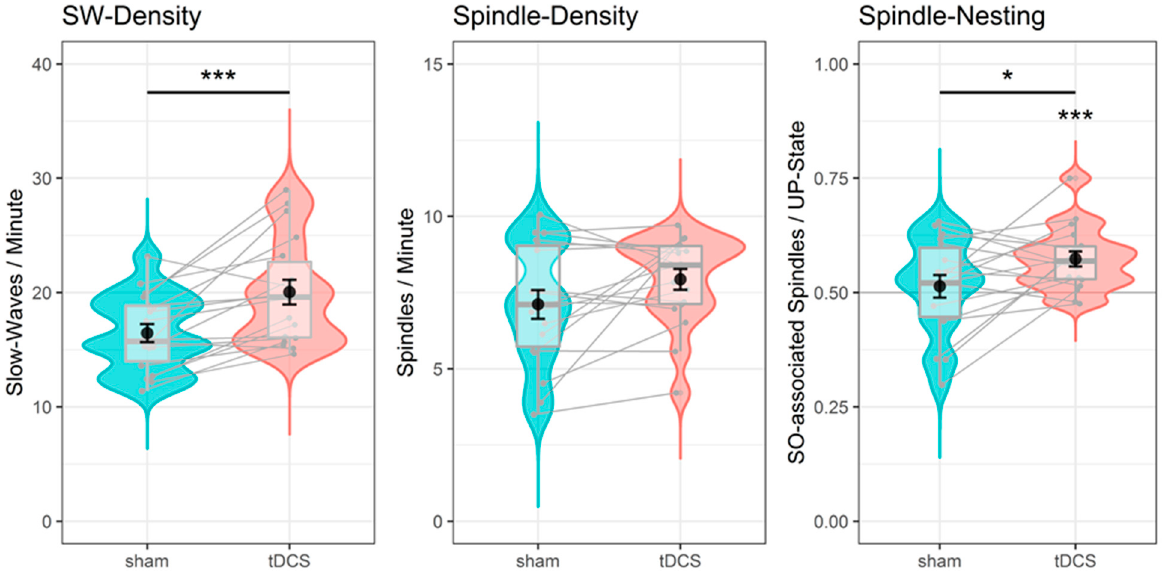
Figure 4. Effect of tDCS on sleep parameters. Slow-wave density ( left panel ), spindle density ( middle ), and nesting of slow-wave-associated spindles in up states ( right ). Plotted are the single participant averages (white dots), the probability densities, boxplots with median and interquartile ranges (grey), and the mean ± SE (black) for the sham (red), and the tDCS (blue) condition. tDCS significantly increased slow-wave density and the nesting of spindles in up states. Spindle nesting exceeded chance level of 0.5 only in the tDCS condition; * p < 0.05, *** p <